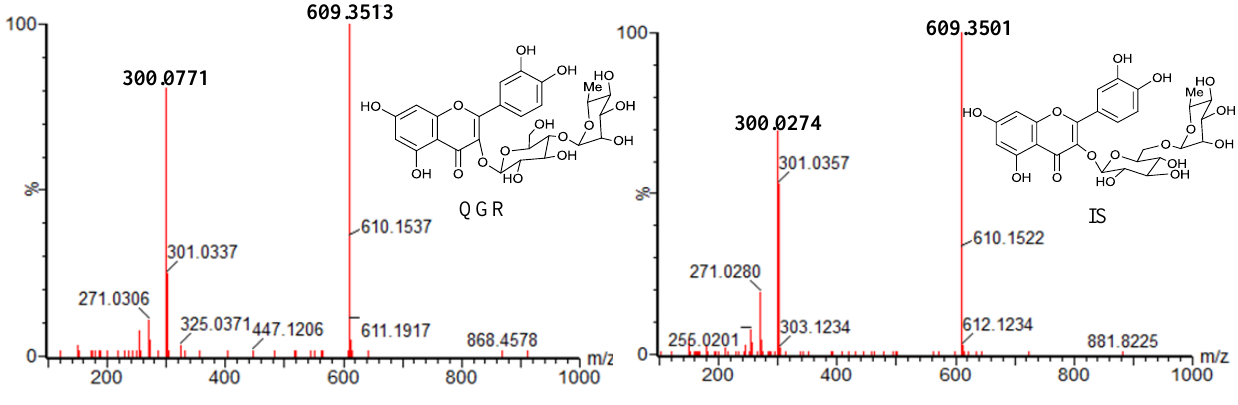
Figure 3. Full-scan product ion spectra of [M−H] − ions and fragmentation schemes for QGR (C H O , MW = 610) and IS (C 27 30 16